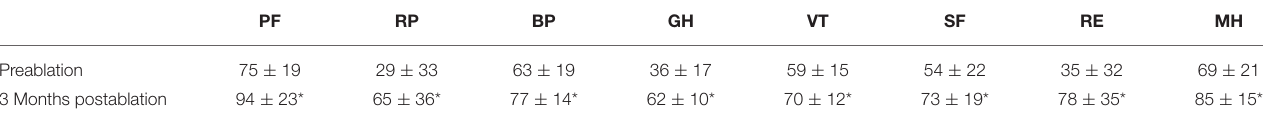
TABLE 3 | Quality of life scores in pre- and postablation. PF RP BP GH VT SF RE MH Preablation 75 ± 19 29 ± 33 63 ±